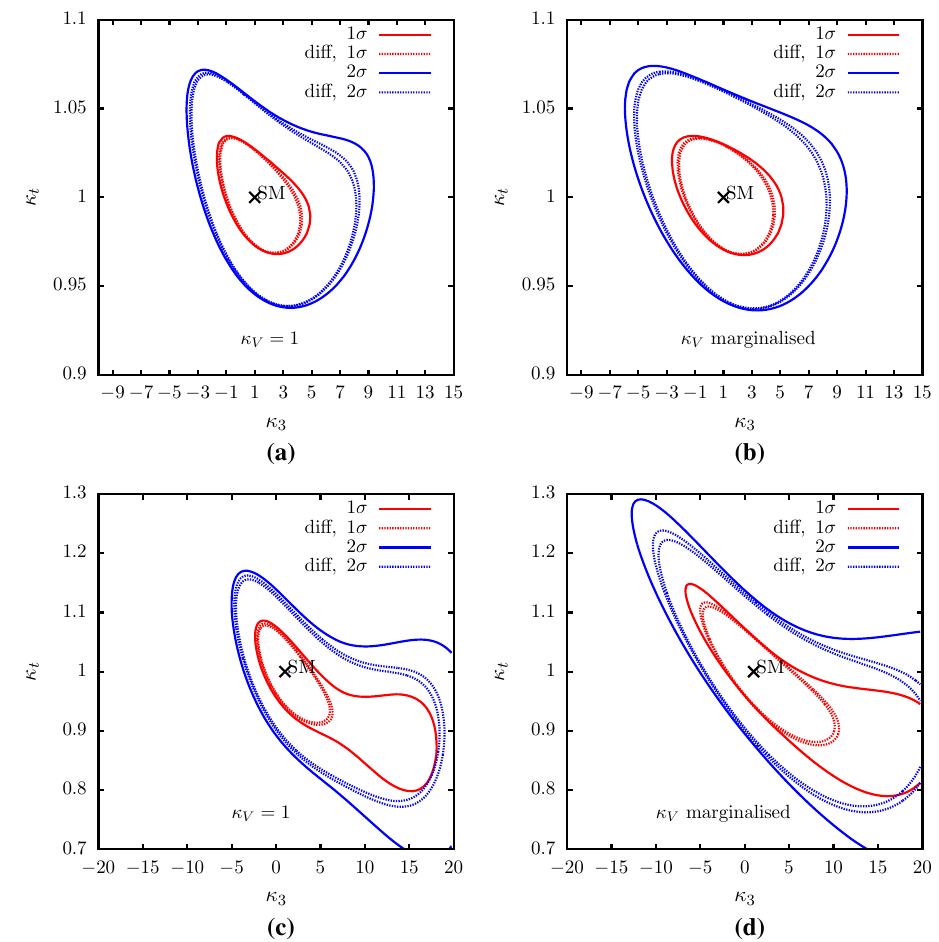
Fig. 14 Bounds on κ t and κ 3 . Left: κ V = 1. Right: κ V marginalized. Upper: all channels considered in the fit. Lower: Only V H and t ¯ tH considered in the